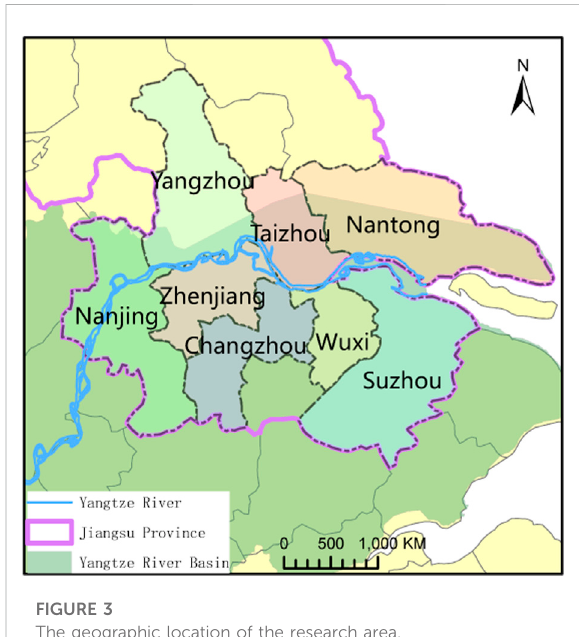
FIGURE 3 The geographic location of the research